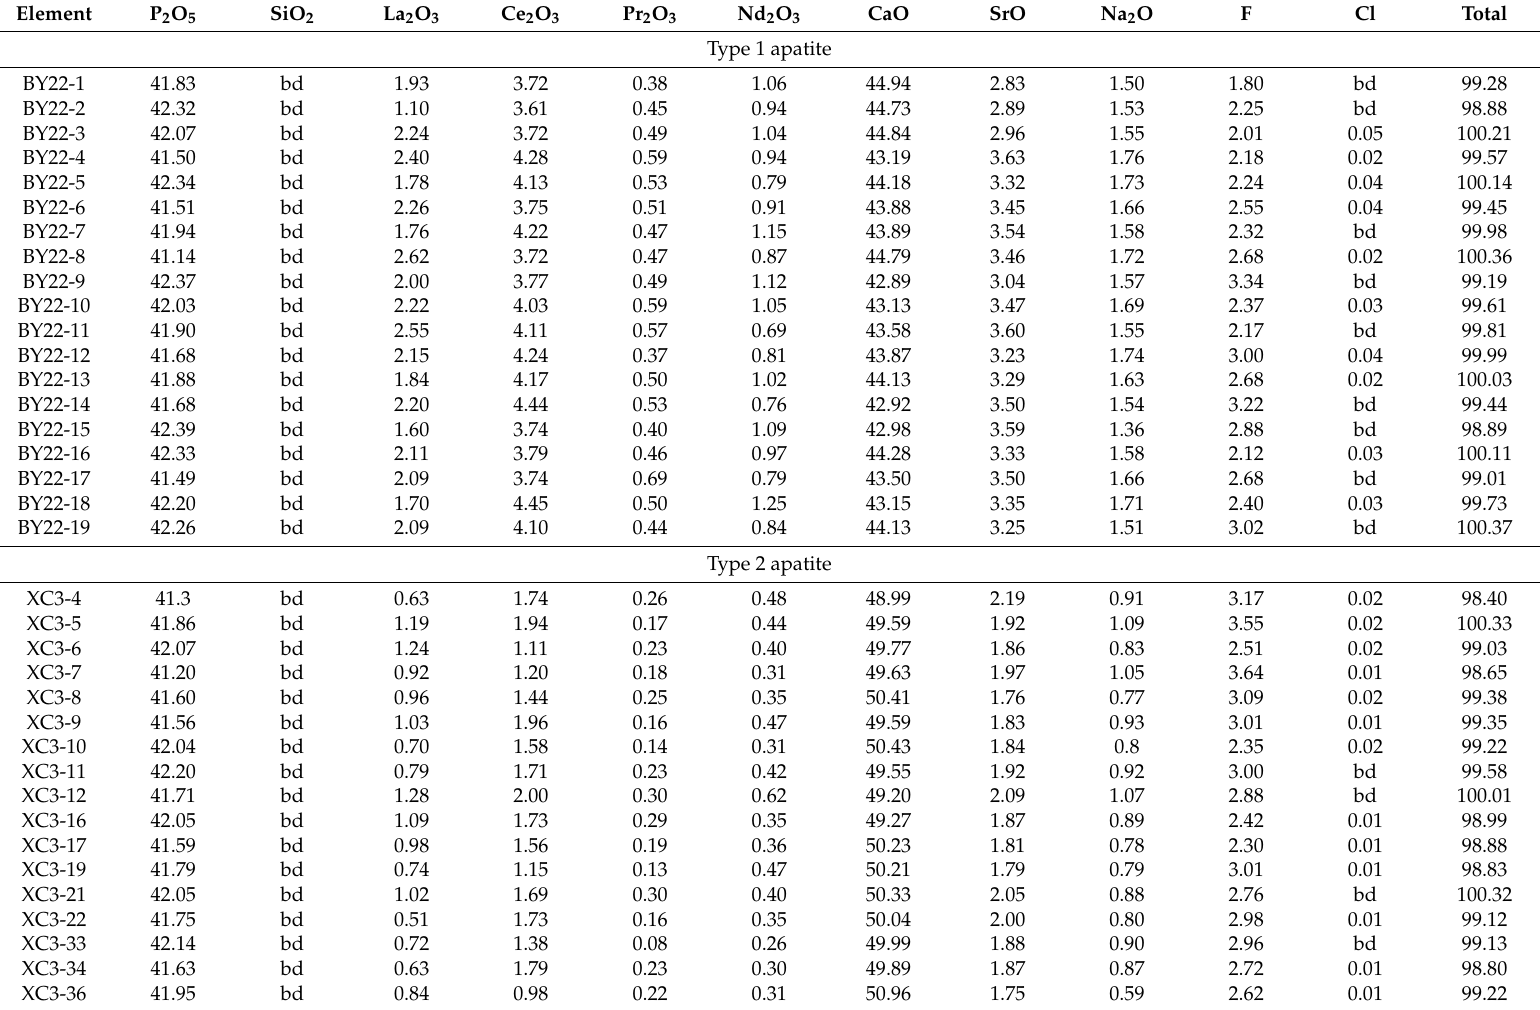
Table 3. Major element concentrations (wt.%) of the three types of apatite in the